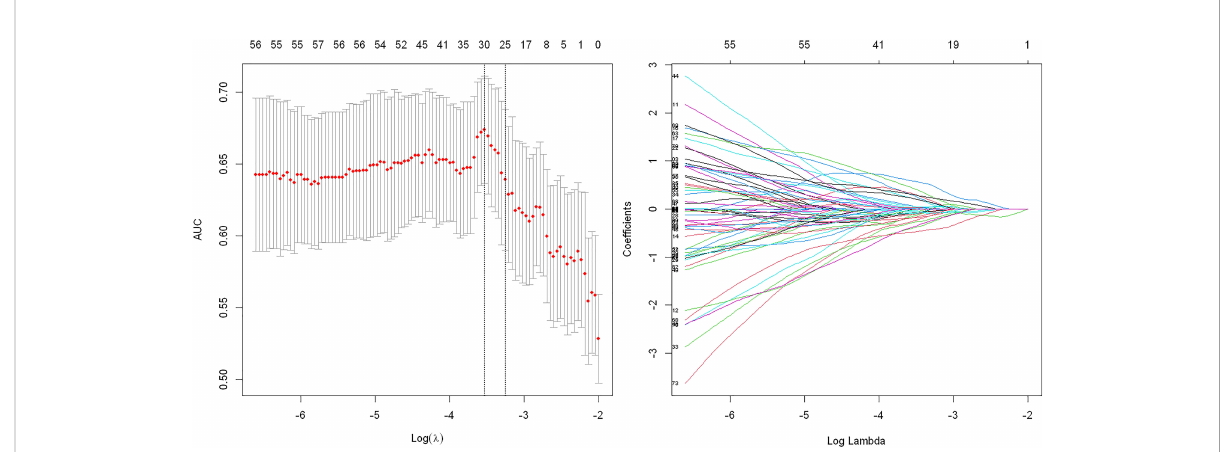
FIGURE 3 Texture feature selection using the least absolute shrinkage and selection operator (LASSO) binary logistic regression model for Gleason score subgroups. Tuning parameter: dotted vertical lines were drawn at the optimal values using the minimum criteria and ( l ) standard error of the minimum criteria. The area under the receiver operating characteristic curve (AUC) was plotted against log ( l ). The value of 0.6893 was chosen, and the optimal ( l ) resulted in 30 nonzero coef fi